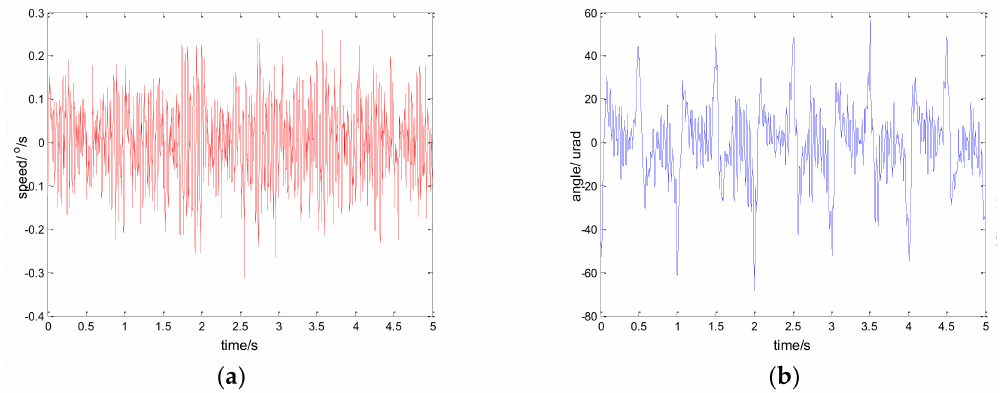
Figure 11. Experiment results of robust SMC with NTD. d = sin ( 2 π t ) : ( a ) speed; and ( b ) tracking error, RMS = 17.5528